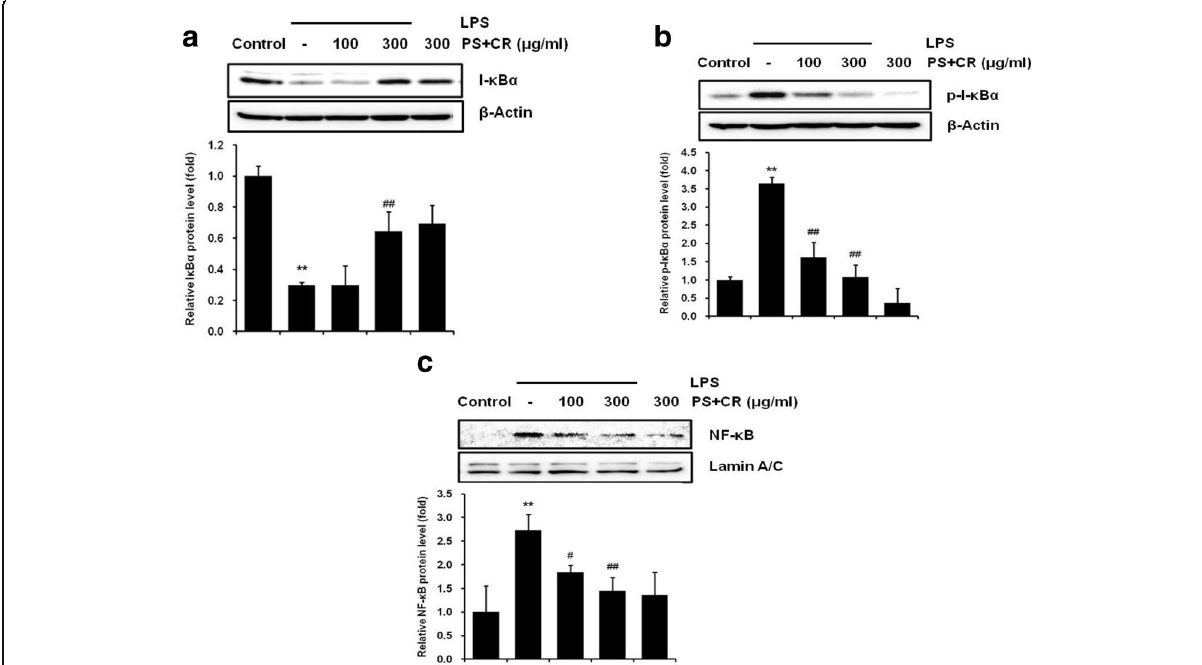
Fig. 5 Inhibition of LPS-induced nuclear factor-kappa B (NF- κ B) protein expression by PS+CR. ( a , b ) Levels of I- κ B α and phospho-I- κ B α . RAW 264.7 cells were treated with 100 and 300 μ g/ml of PS+CR for 1 h prior to the addition of lipopolysaccharide (LPS) (1 μ g/ml) and further incubated for 30 min. Cytosol fraction proteins were separated by SDS-PAGE. β -Actin was used as a loading control, and the bar chart shows the quantitative evaluation of I- κ B α and phospho-I- κ B α bands by densitometry. (c) The levels of NF- κ B. RAW 264.7 cells were treated with 100 and 300 μ g/ml of PS+CR for 1 h prior to the addition of LPS (1 μ g/ml) and further incubated for 1 h. Nuclear fraction proteins were separated by SDS-PAGE. Lamin A/C was used as a loading control, and the bar chart shows the quantitative evaluation of NF- κ B bands by densitometry. Values represent the mean±S.D. of three independent